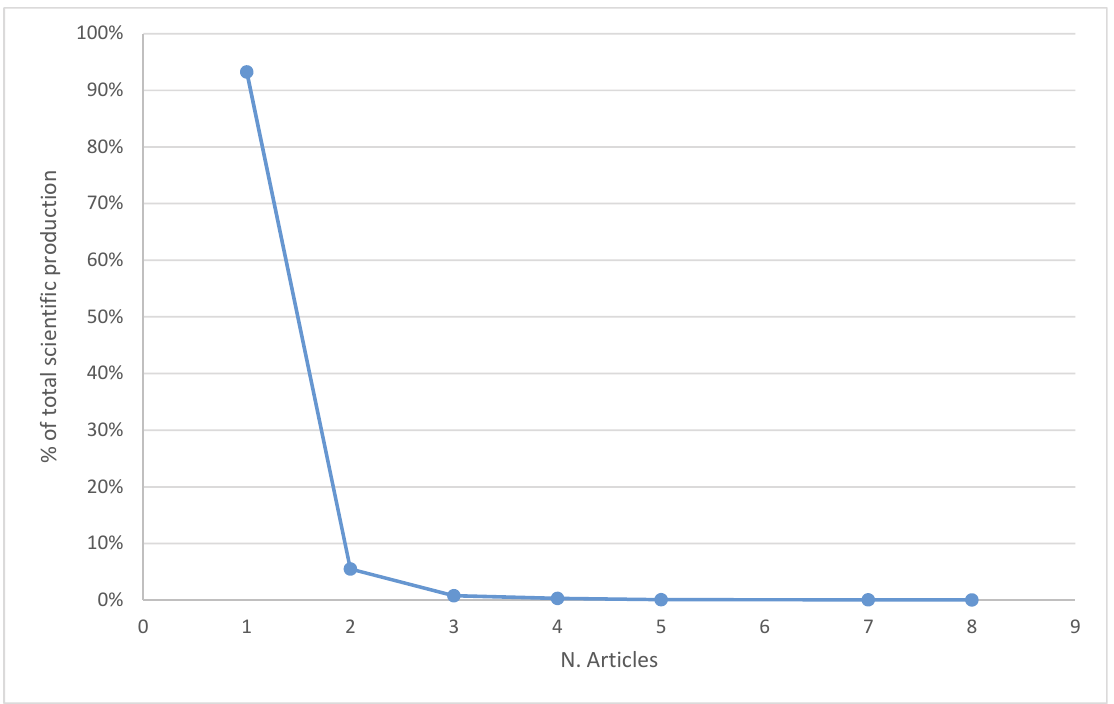
Fig. 5. Author scientific